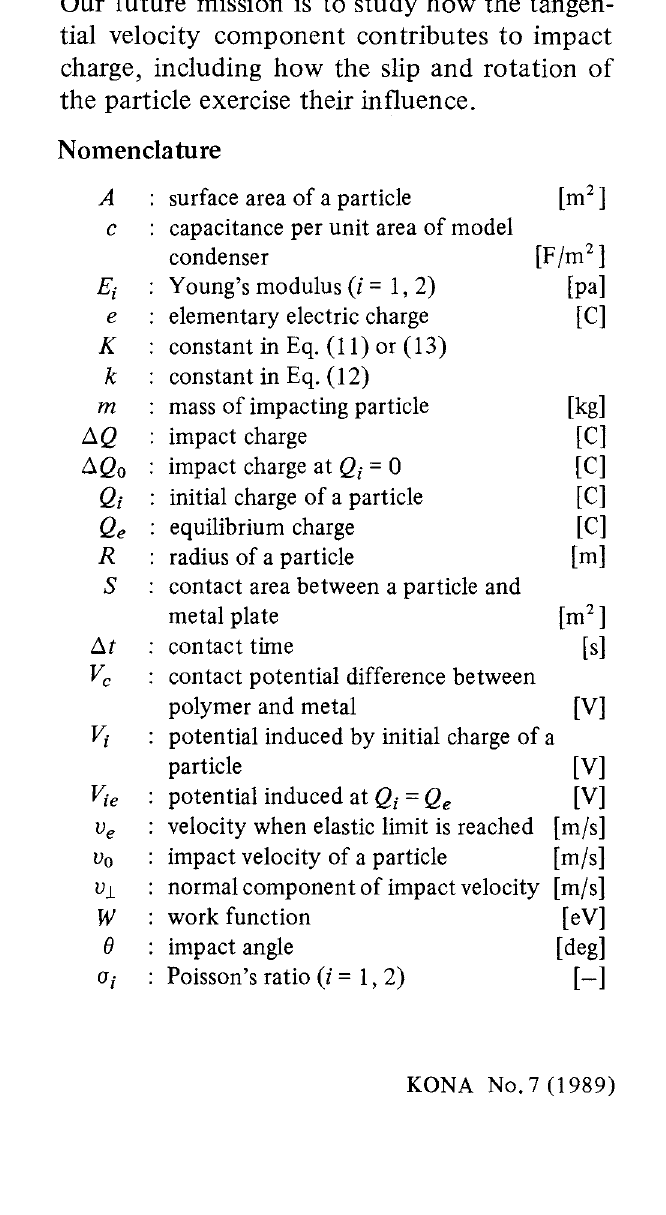
Fig. 6 Impact charge vs normal velocity (Aluminum plate vs